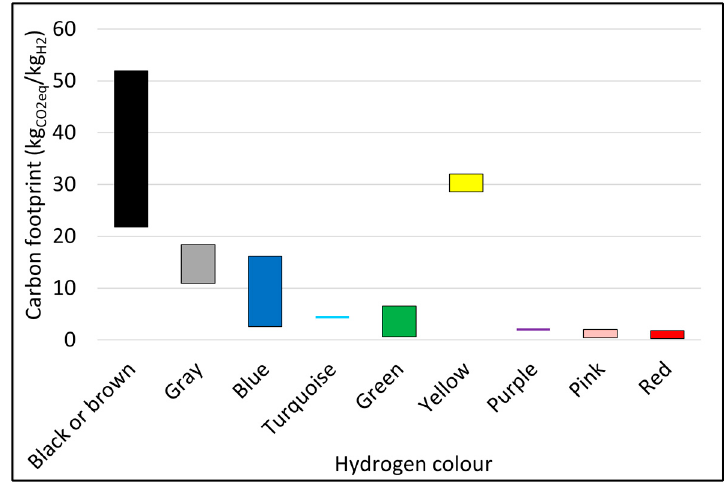
Figure 1. Carbon footprints of various hydrogen colors. Table 2. Hydrogen color codes, sources, and their carbon footprints (abbreviations: CCS: carbon capture and storage; SMR: steam methane reforming; ATR: autothermal reforming; NGD: natural gas decomposition; n.a.: not available).